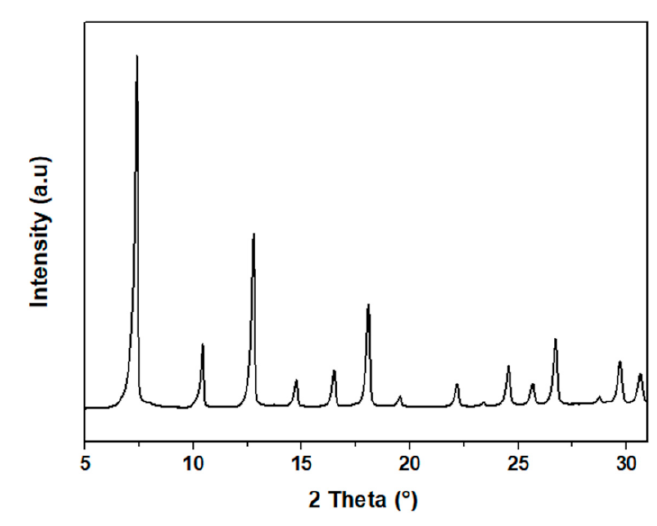
Figure 2. X-ray diffraction (XRD) of ZIF-8 nanoparticles.